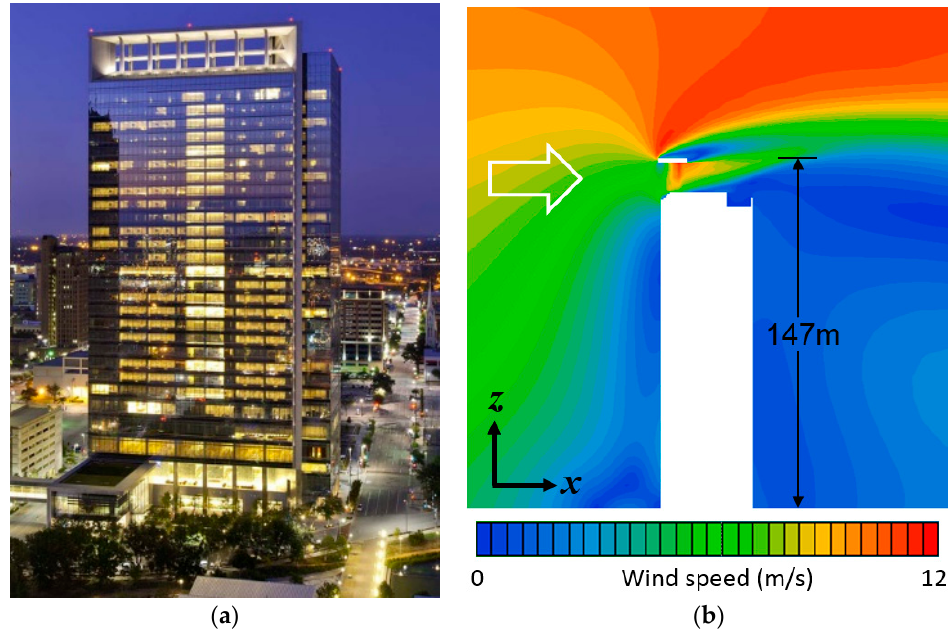
Figure 2. The Hess Tower: ( a ) photo from the front of the wind turbines; and ( b ) contour plot of wind speed on a vertical cross-sectional plane (CFD by the authors).